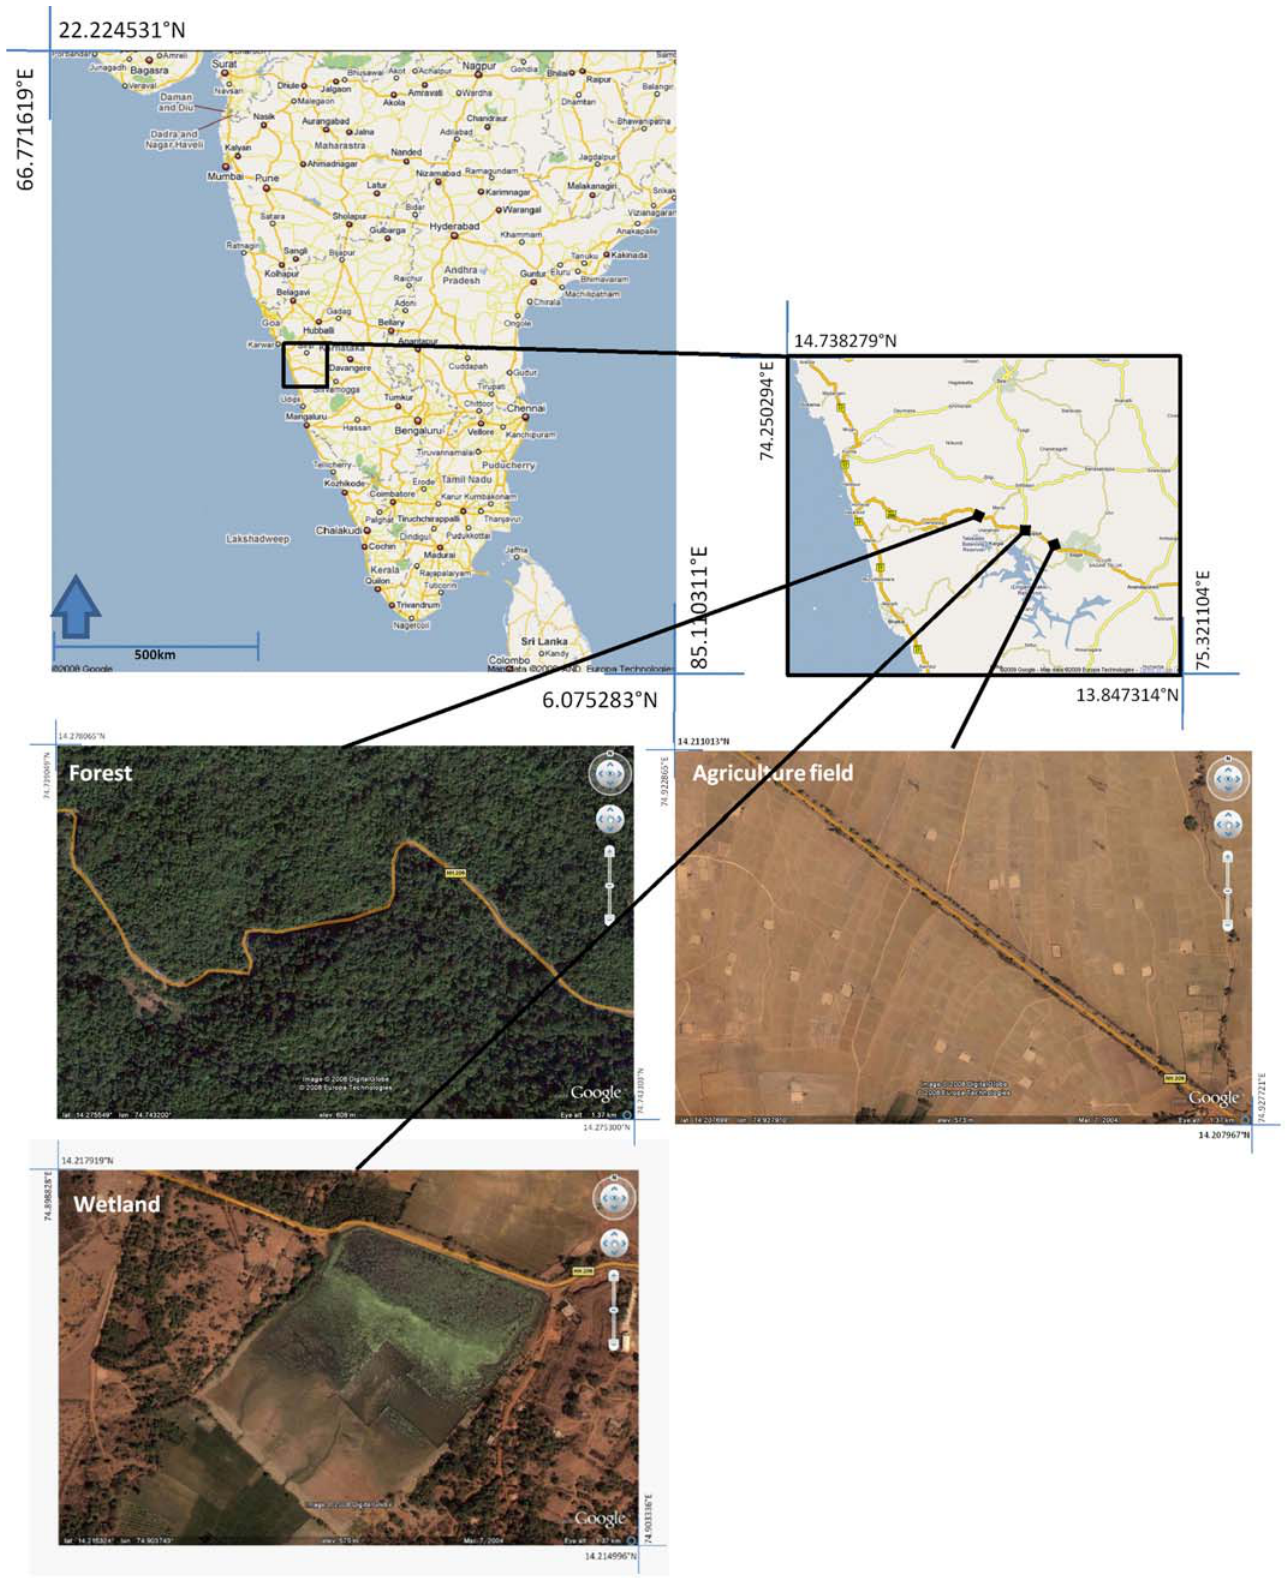
1. Maps indicating the study area and zoomed in images of forest, agriculture field and wetland with sampling stretch of road (National Highway 206) passing through them (yellow line in the zoomed images). Image source: Google Earth,